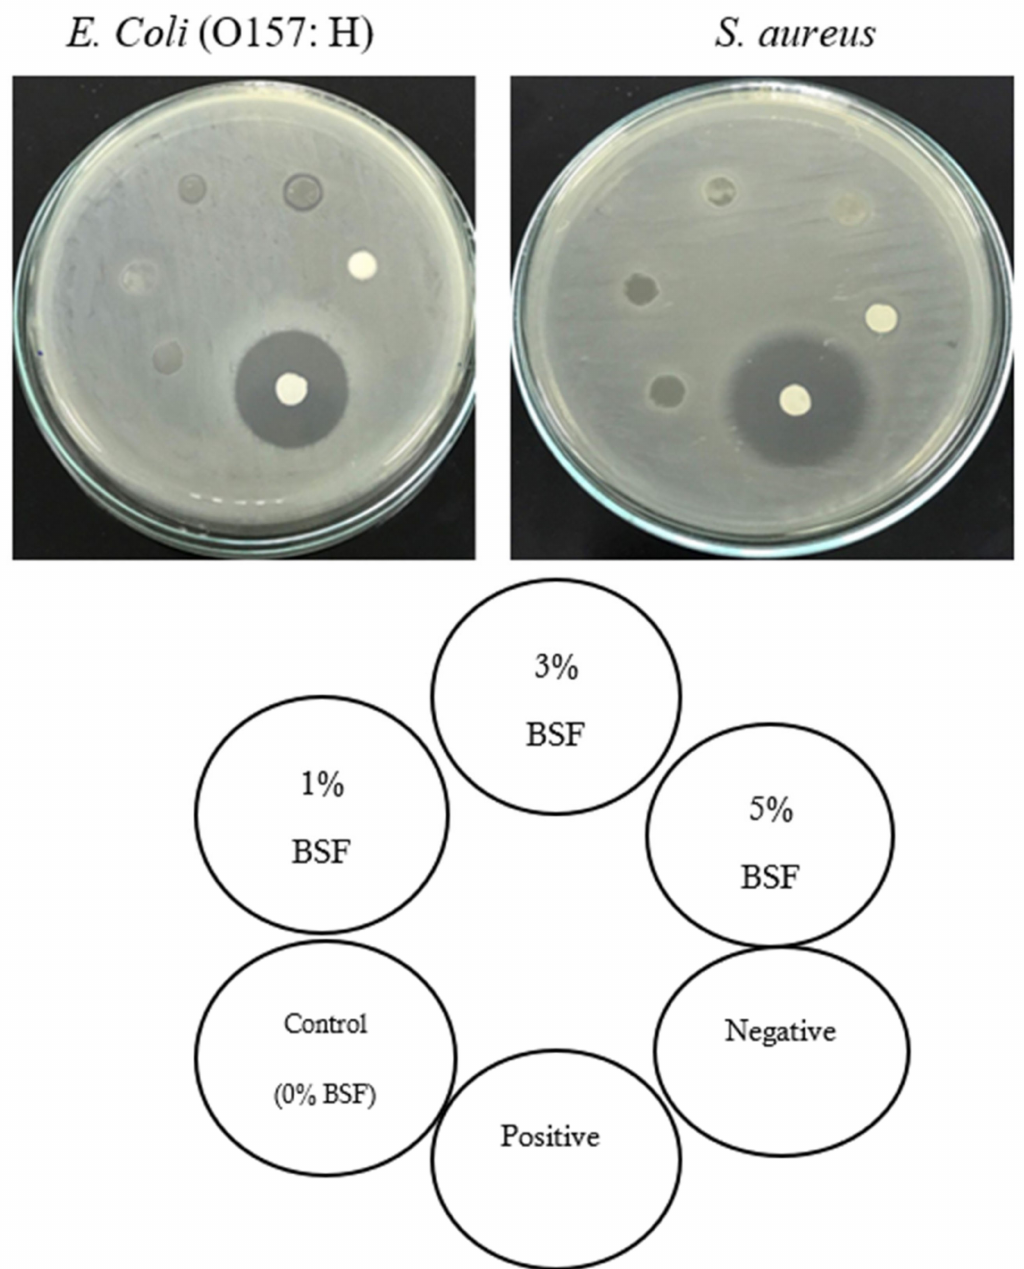
Figure 2. Antimicrobial properties of banana starch films incorporated with banana peel extract at different concentrations against E. coli (O157: H7) and S. aureus (TISTR 1466). Negative: distilled water (30 µ g/disc); Positive: ampicillin (30 µ